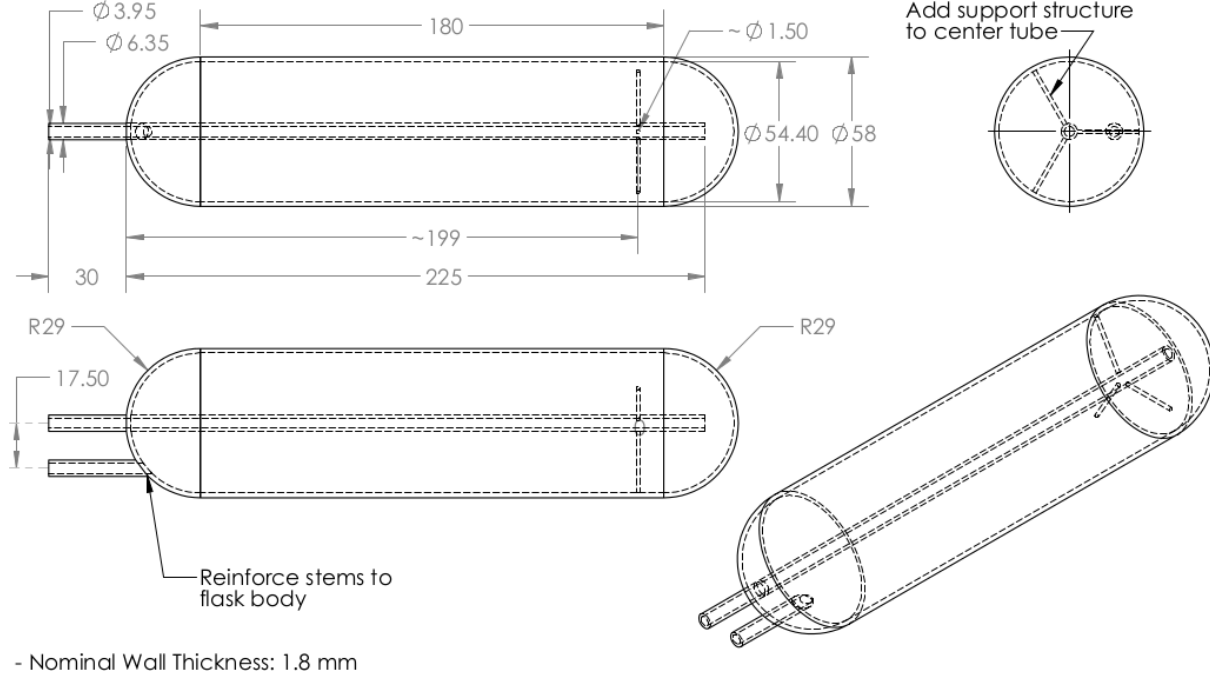
Figure A2. Design document for the glass flasks aboard the S2 payload.